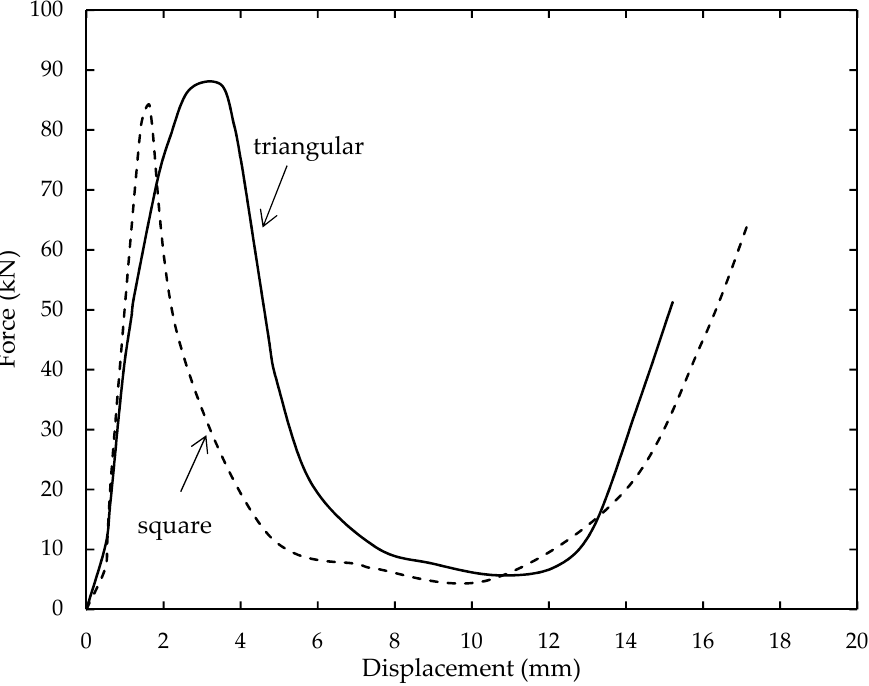
Figure 10. Typical force-displacement traces of square and triangular core structures.